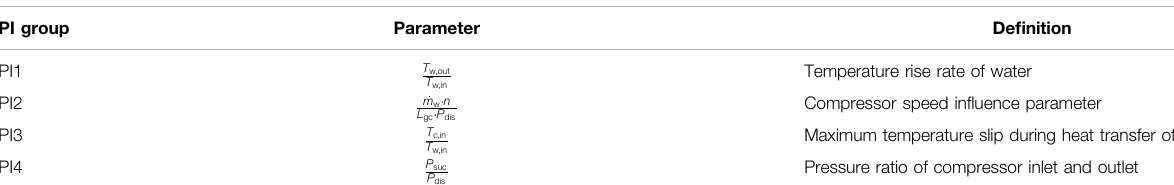
TABLE 5 | Speci fi c parameters of PI groups.